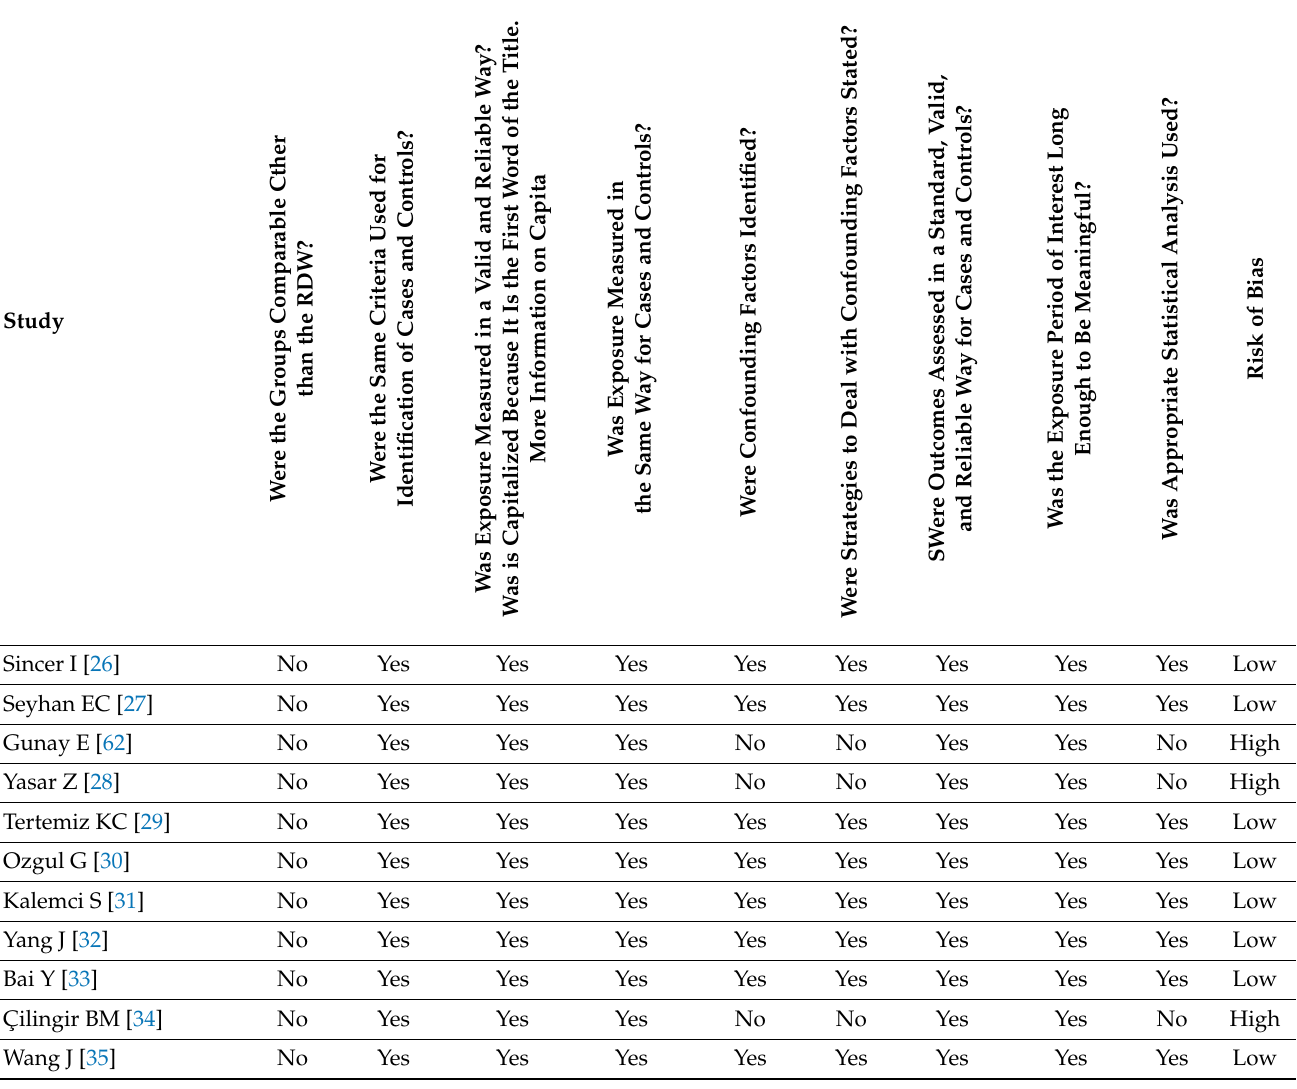
Table 3. The Joanna Briggs Institute critical appraisal